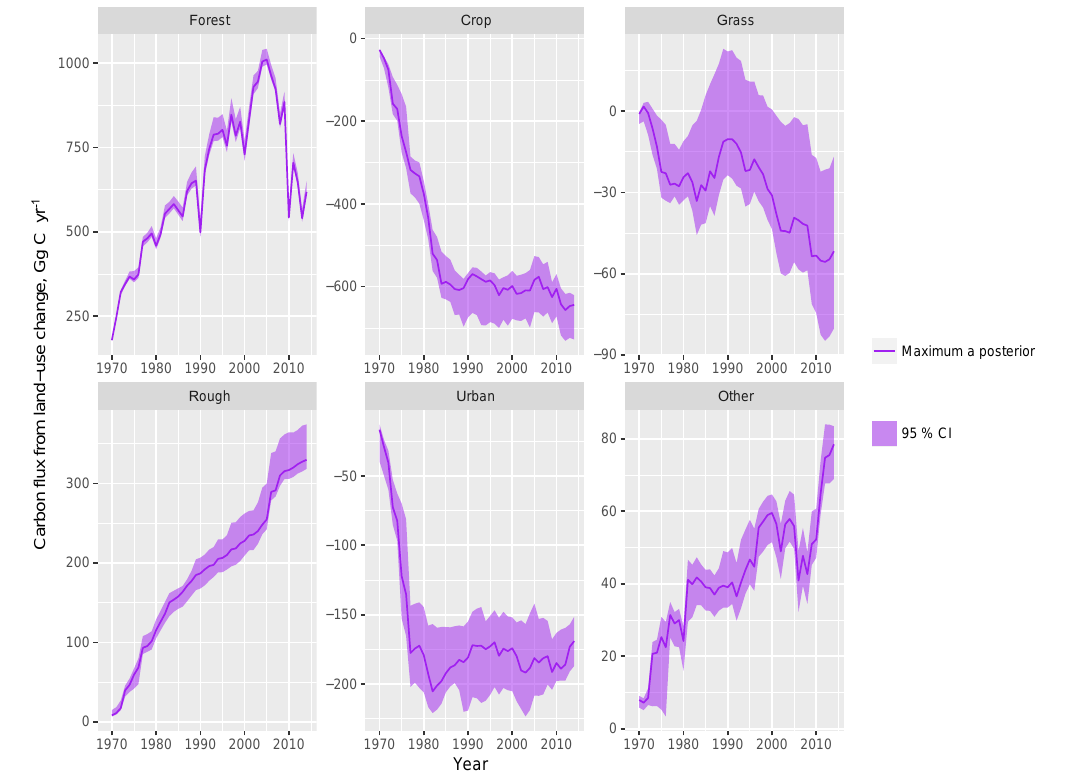
Figure 10. Net carbon flux from land-use change in Scotland over 1969–2015 showing the maximum a posteriori estimate and its 95% credibility interval. The flux is attributed to change to each land-use class u . Positive fluxes denote a gain to the terrestrial carbon stock; negative fluxes represent a loss to the